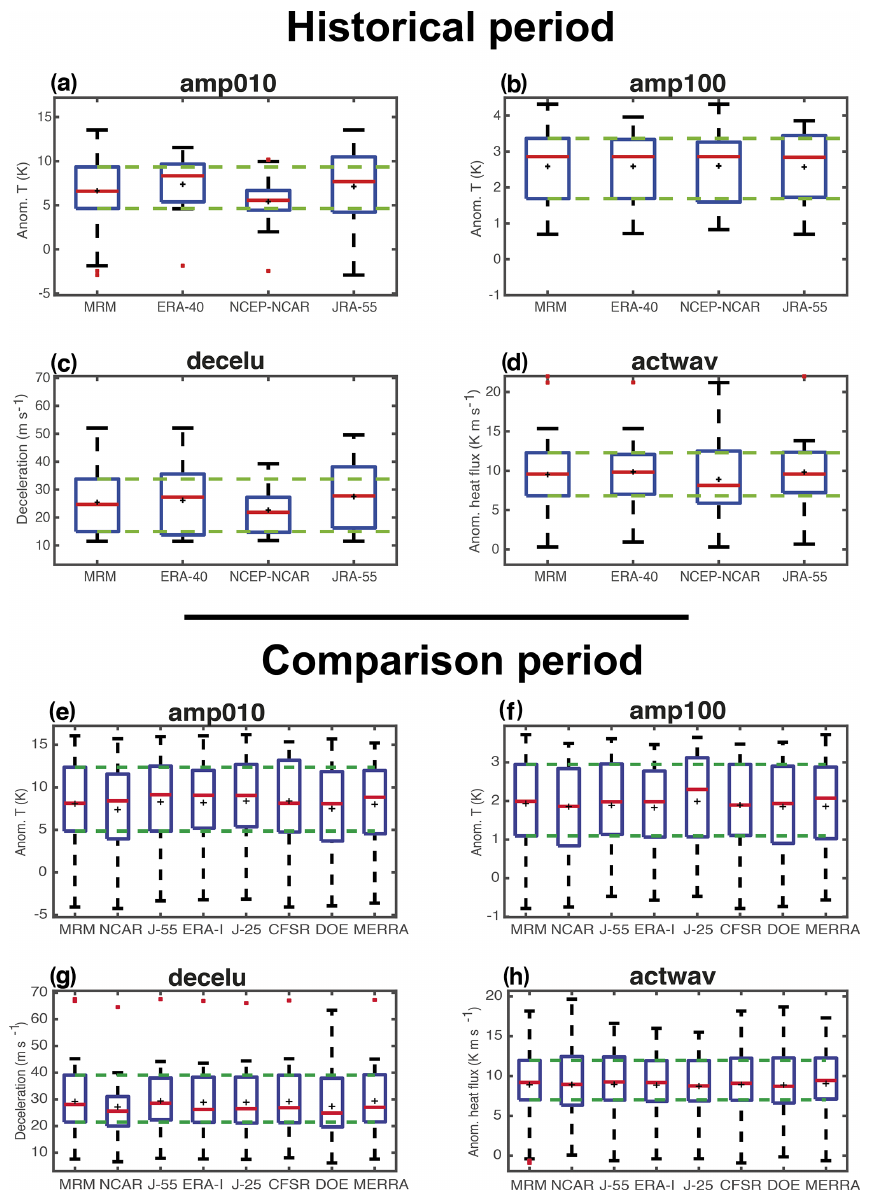
Figure 3. Box plots showing the distribution of the dynamical benchmarks of SSWs (amp010, amp100, decelu, and actwav) in the historical (1958–1978) and comparison (1979–2012) periods. The interquartile range is represented by the size of the box and the red line (black cross) corresponds to the median (mean). Whiskers indicate the maximum and minimum points in the distribution that are not outliers. Outliers (red crosses) are defined as points with values greater than 3 / 2 times the interquartile range from the ends of the box. See text for the definition of dynamical